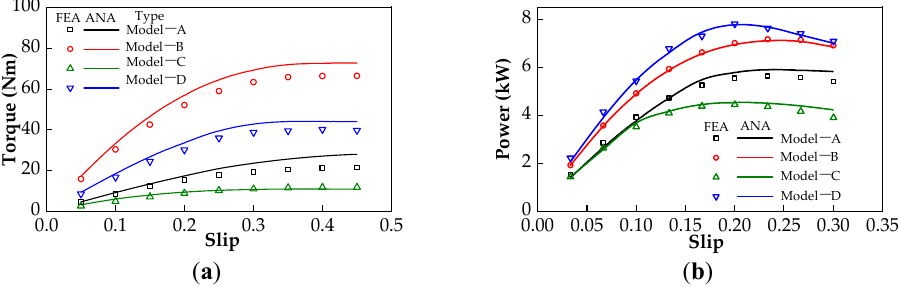
Figure 13. The output torque and output power of the typical PMECCs: ( a ) torque-slip characteristics; ( b ) power-slip characteristics.